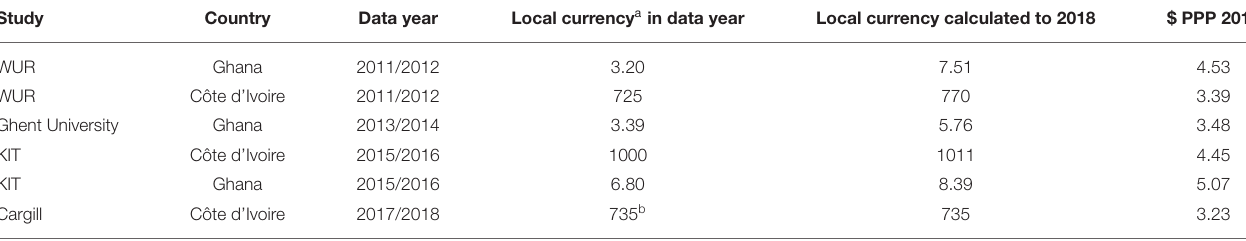
TABLE 2 | Standardization of cocoa prices per kg to $ purchasing power parity ($ PPP